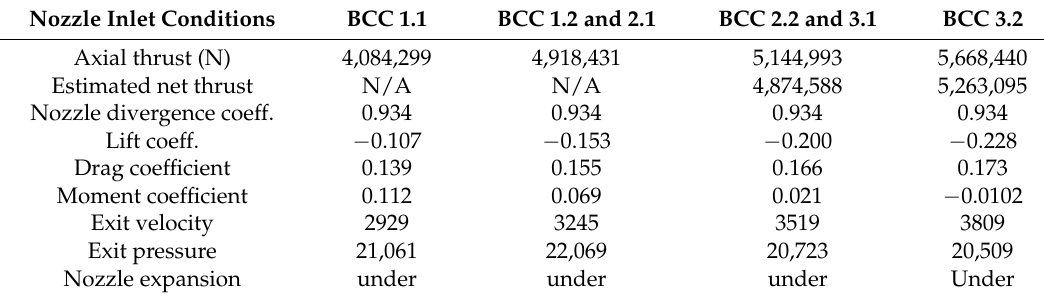
Table 10. SERN DP102 overall performance at each BCC.